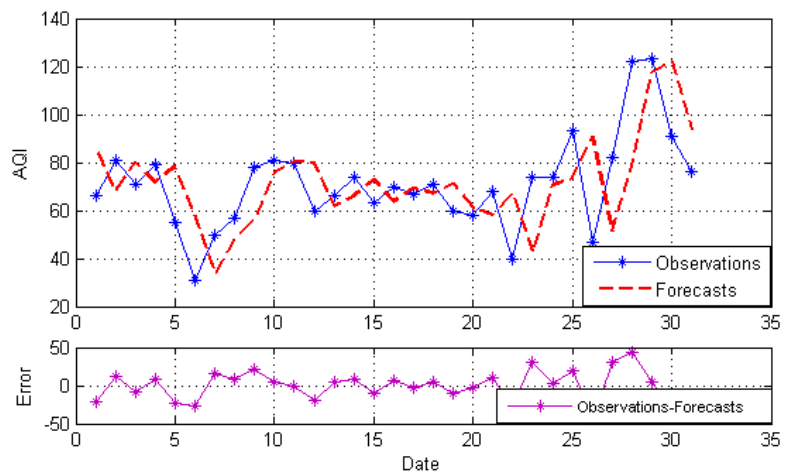
Figure 6. The forecasts and error based on EEMD-MM-ES.